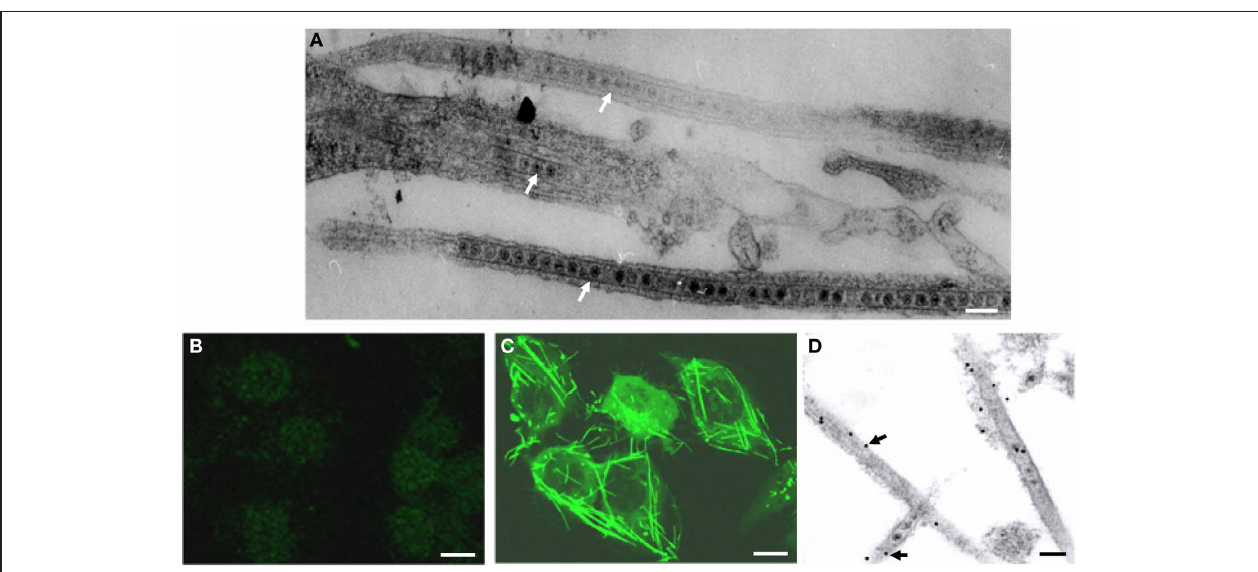
FIGURE 2 | Viral non-structural protein Pns11 is the constituent of the tubules induced by RGDV infection in VCMs at 48hpi. (A) Electron micrograph of virus-containing tubules within the cytoplasm or protruding from the surface of infected cells. Bar, 100nm. (B) Immunofluorescence staining of Pns11 showing nothing within uninfected cell. VCMs were immunostained with Pns11-FITC. Bar, 10 µ m. (C) Immunofluorescence staining of Pns11 showing tubule-like structures within the cytoplasm and